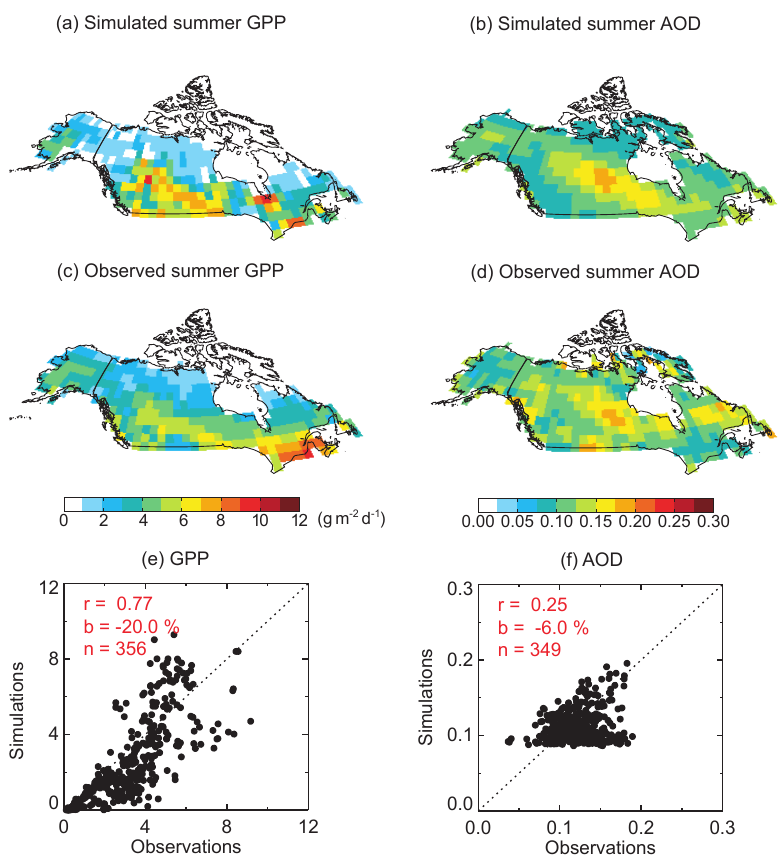
Figure 3. Evaluation of simulated summer (a) GPP and (b) AOD at 550nm with (c, d) observations. Simulation results are from F10AERO (Table 1). Each point on the (e, f) scatter plot represents one grid square in boreal North America. The number of points ( n ), correlation coefficient ( r ), and relative bias ( b ) for the evaluation are presented on the plot.